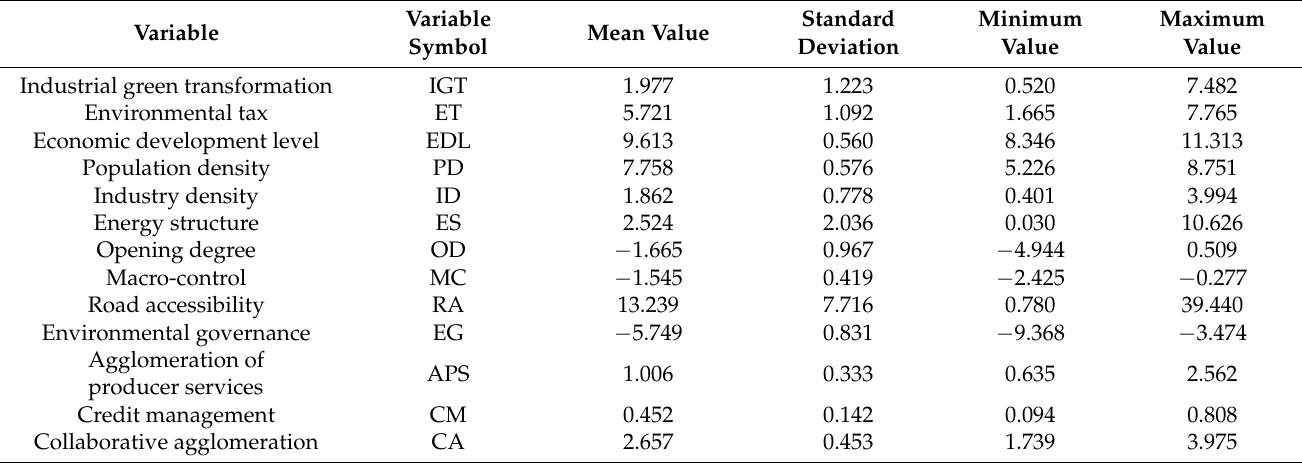
Table 1. Variable descriptive